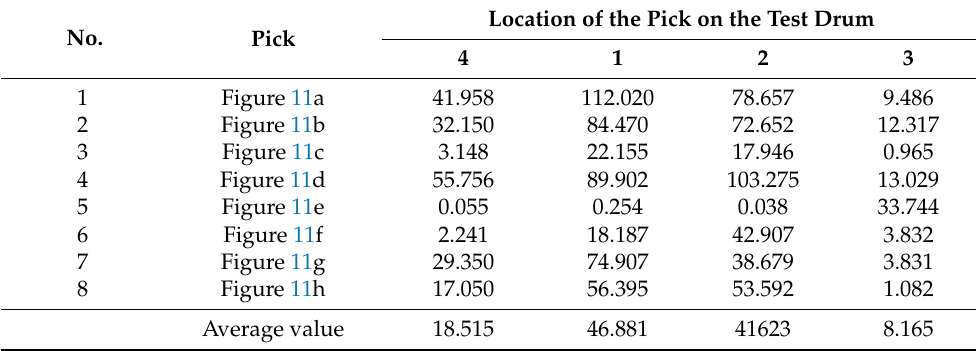
Table 8. Summary of C 2 index values for the tested picks depending on the location on the test